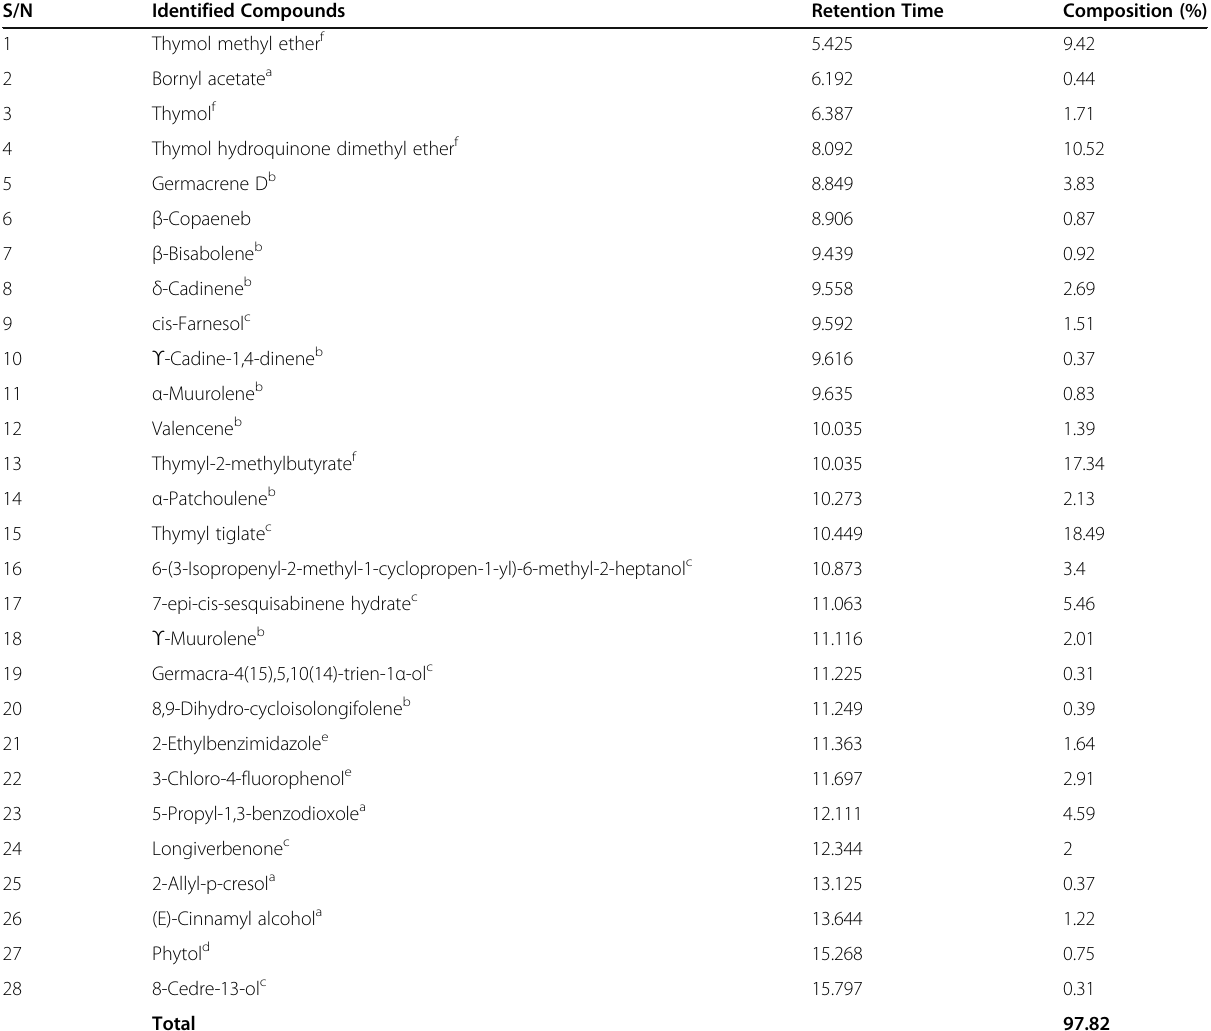
Table 1 Constituents of Essential oil from the leaf of A. flagellaris S/N